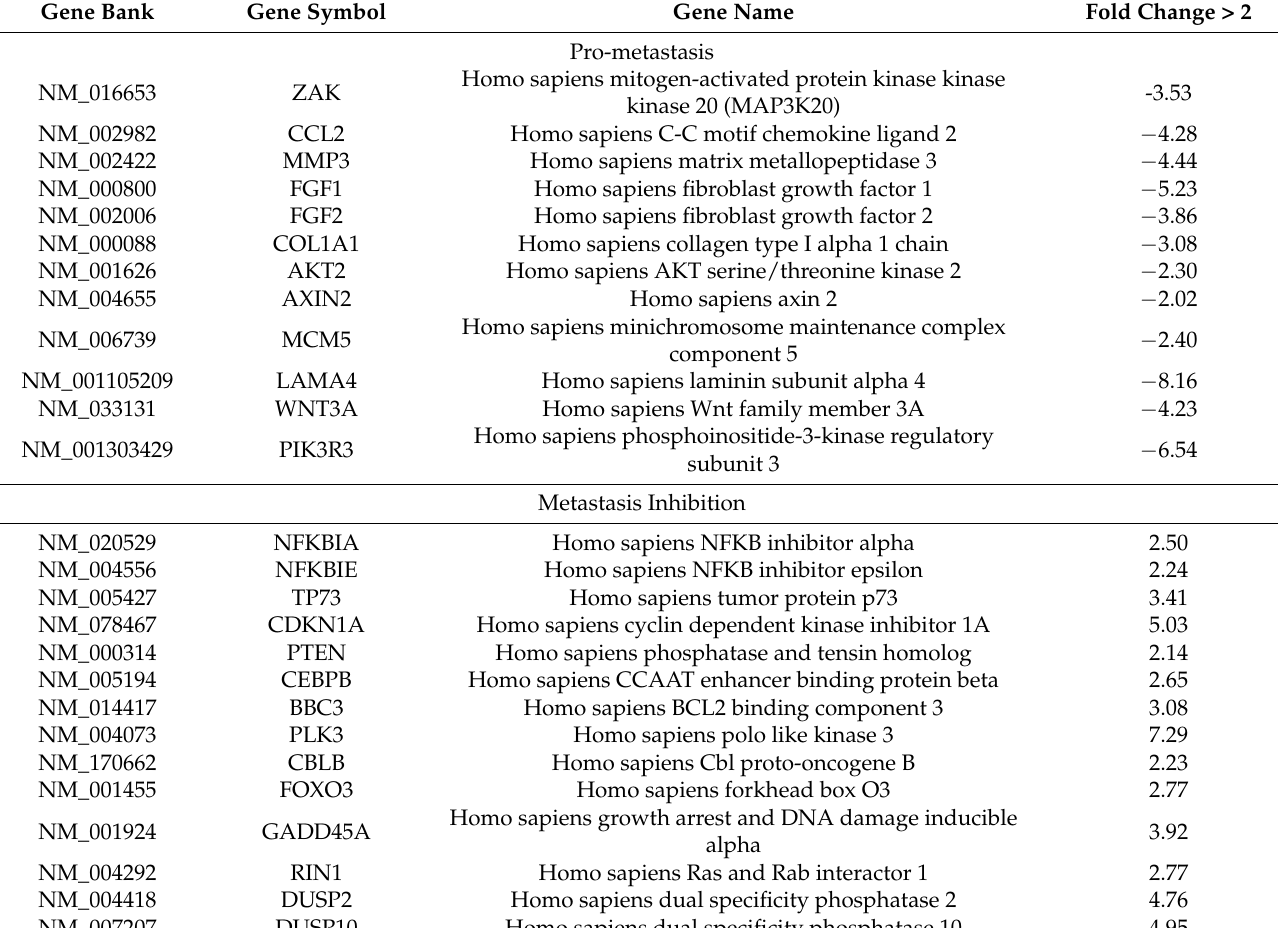
Table 1. List of regulated genes, associated with either in promoting cell metastasis or results in inhibitory activity for U-2 OS treated with DK1 (IC 50 ) compared with untreated